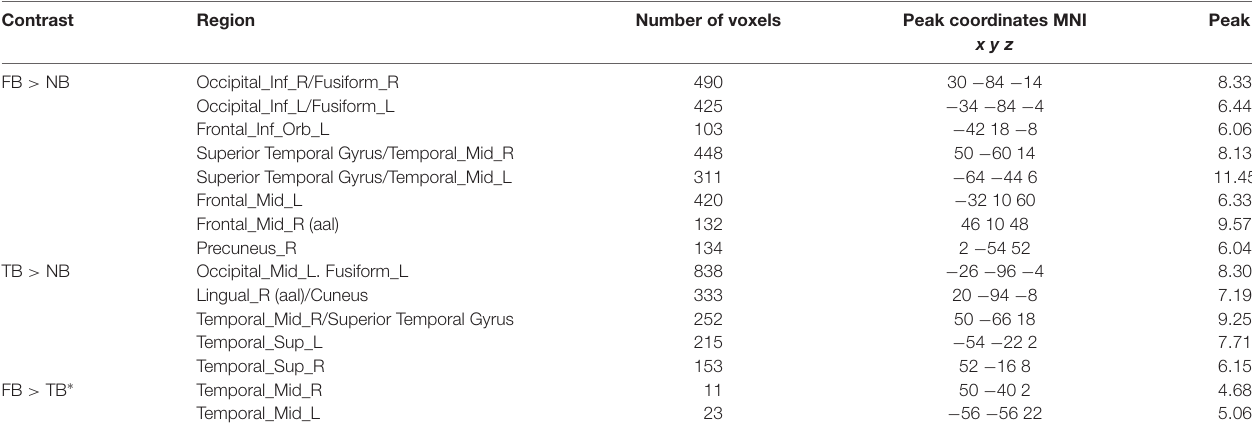
TABLE 2 | fMRI BOLD activations for contrasts of interest (whole-brain